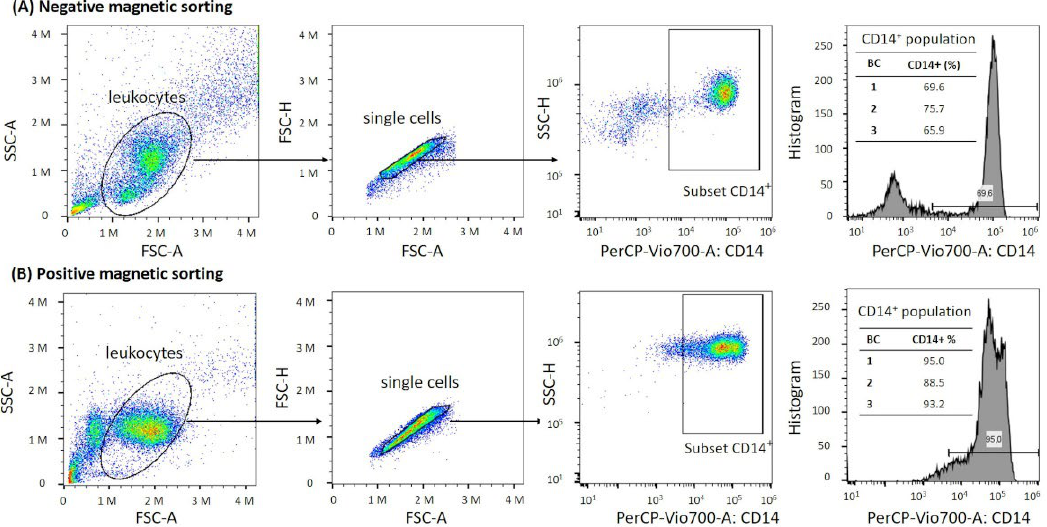
Figure 3. Gating strategy for quantifying the percentage of CD14 + monocytes from the leukocyte population after negative magnetic sorting ( A ) and positive magnetic sorting ( B ). The viable leukocyte population was first individualized by crossing the singlet gate and gating on the CD14 + gate. The threshold for CD14 + cells was evaluated by data from the histograms and unstained controls. The respective histogram of BC1 is shown as an example. The tables show the percentage of CD14 + monocytes of viable leukocytes for each BC. Abbr.: SSC-A, side scatter area; FSC-A, forward scatter area, CD14, cluster of differentiation 14.